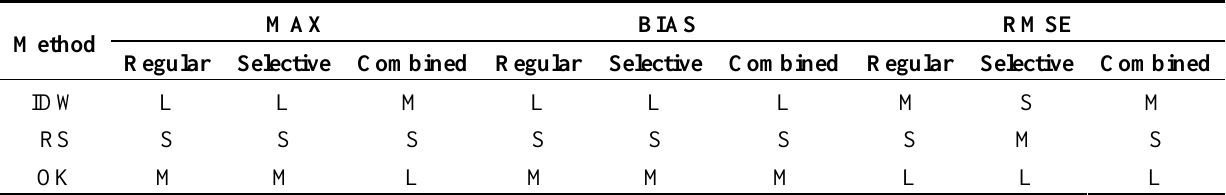
Table 10. The results of the three interpolation